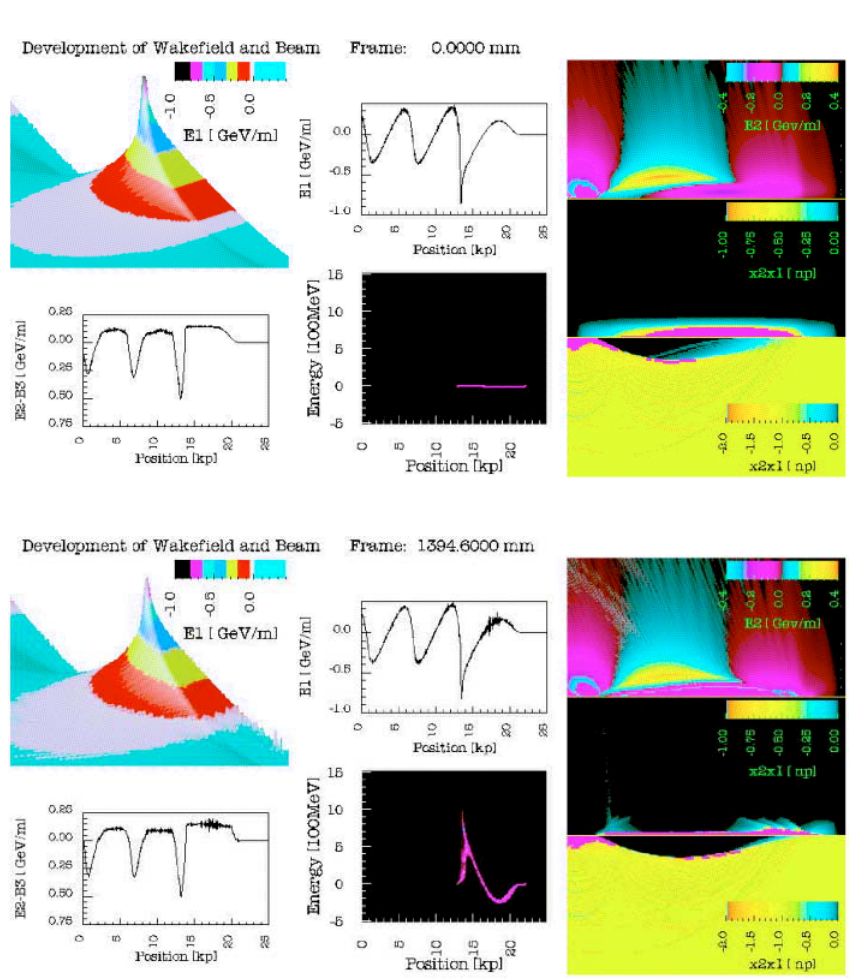
FIG. 1. (Video) The first and the last frames of the video accompanying this paper. The different plots of the video are (column by column from the top to the bottom) E z : rubber sheet; E r - B u : focusing field lineout s r off axis; E z : lineout on axis, beam-energy change as a function of z - ct ; E r in the r - z plane; n beam in the r - z plane; n plasma in the r - z plane (direction of r reversed). Please note that in the figures and the video the indices 1, 2, and 3 are used instead of z , r , and u